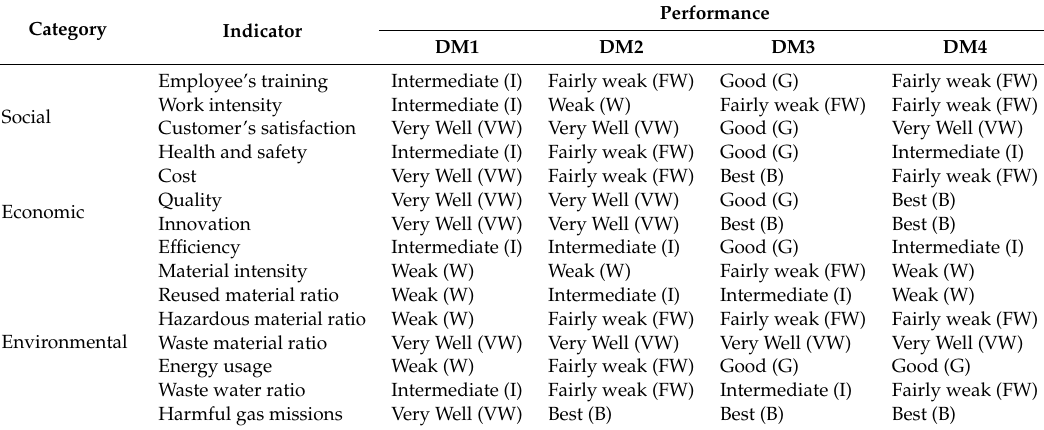
Table 5. The judgements of four DMs concerning the performance of selected